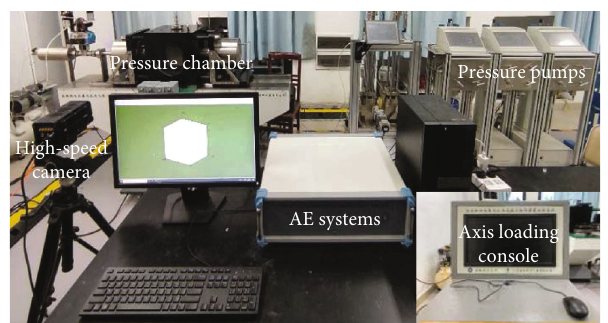
Figure 1: Three-axis dynamic and static loading experimental system.